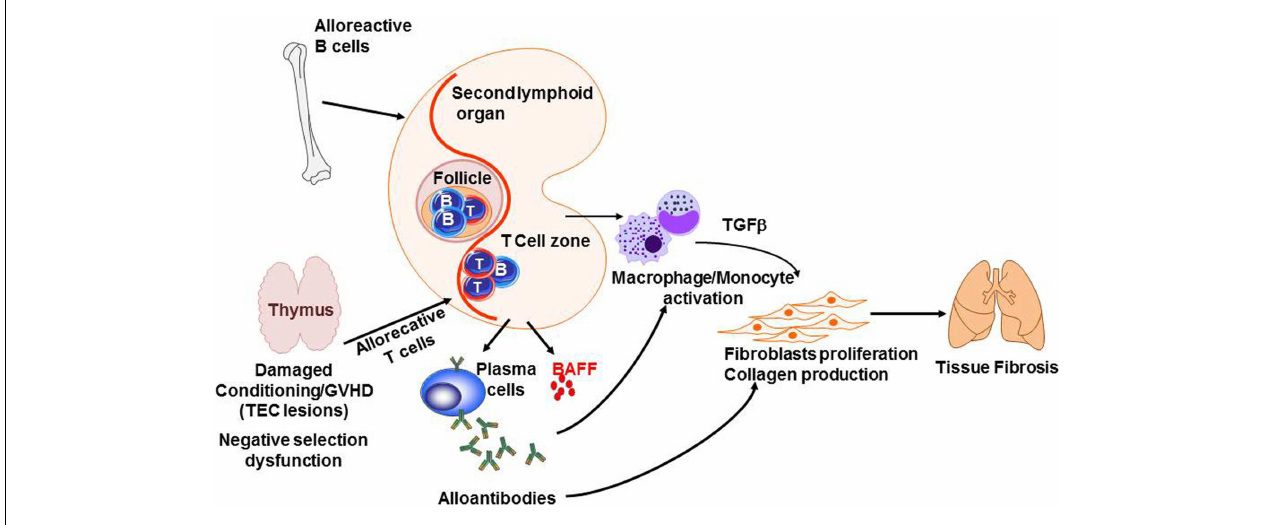
cytokines and chemokines produced by B- andT-cells activate macrophages and monocytes.Together, antibodies andTGF β induce fibroblasts proliferation and activation as well as collagen production, which results in fibrosis in target organs such as the